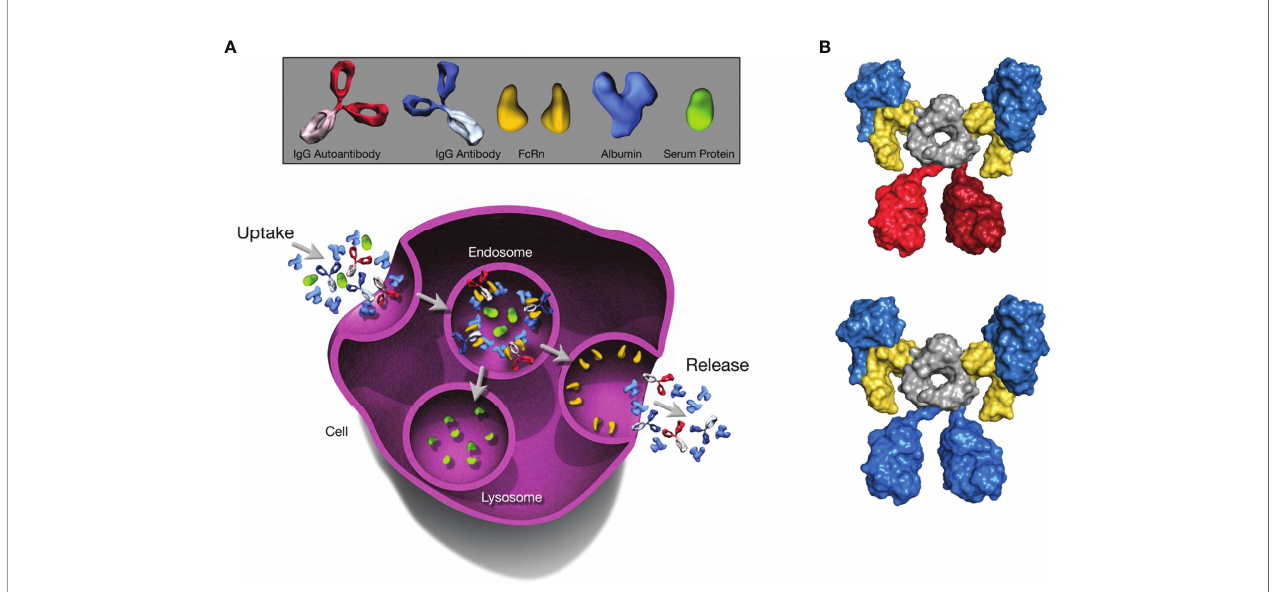
FIGURE 1 | The Role of FcRn in Serum Albumin Regulation. The depicted processes of recycling and transcytosis collectively regulate SA concentration. (A) FcRn- mediated recycling and transcytosis rescue albumin and IgG from intracellular degradation. FcRn-albumin binding is critical for maintaining albumin homeostasis via scavenging, recycling, and transport of the FcRn-albumin-IgG complex through the endosomal recycling pathway. Subsequently, albumin and IgG antibodies are released into the extracellular space via exocytosis, whereas other proteins are degraded in lysosomes. (B) Molecular architecture of the complex between the extracellular region of FcRn (yellow), albumin (blue), and an IgG1 antibody (blue or red). The Fc moiety of an antibody (gray) can recruit 2 FcRn molecules. Simultaneously, each FcRn molecule can bind 1 additional albumin molecule (blue). All molecules are shown in surface representation. Figure generated with PyMOL using PDB entry 4N0U (30). Beta-2 microglobulin not shown. FcRn, neonatal Fc receptor; IgG, immunoglobulin G; SA, serum